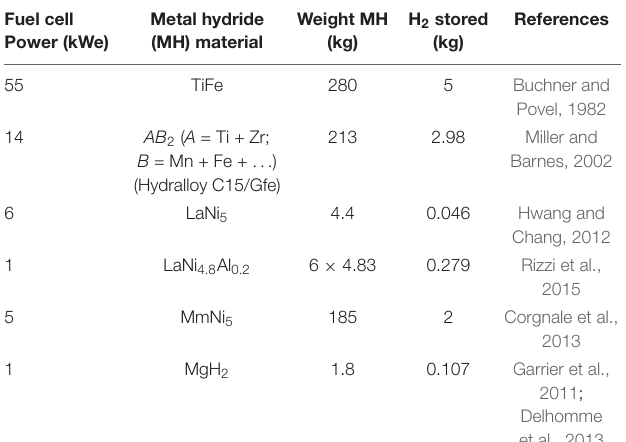
TABLE 3 | Examples of integration of MH in fuel-cell systems (Buchner and Povel, 1982; Miller and Barnes, 2002; Garrier et al., 2011; Hwang and Chang, 2012; Corgnale et al., 2013; Delhomme et al., 2013; Rizzi et al., 2015; Lototskyy et al., 2017). Fuel cell Power